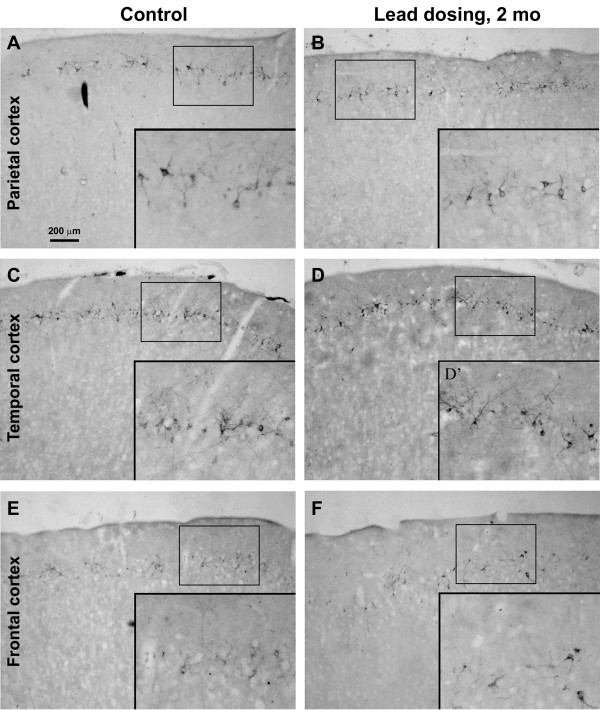
Doublecortin-immunoreactive (DCX+) cells in different cortical areas from Pb exposure and age-matched control groups surviving 2 months. Left panel images show parietal (A), temporal (C) and frontal (E) cortices from a control animal. Right panel images (B, D, F) show images from comparable regions in a Pb-treated animal. Inserts show closer view of the labeled cells, with arrows pointing to medium to large sized, and small sized cells. Overall, the amount and morphology of DCX + cells appear to be comparable between the two groups. Scale bar in panel A = 200 μm applying to main panels, equivalent to 100 μm for enlarged inserts.